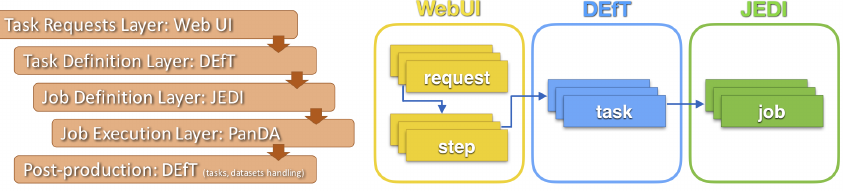
Figure 1. ProdSys2 layers and